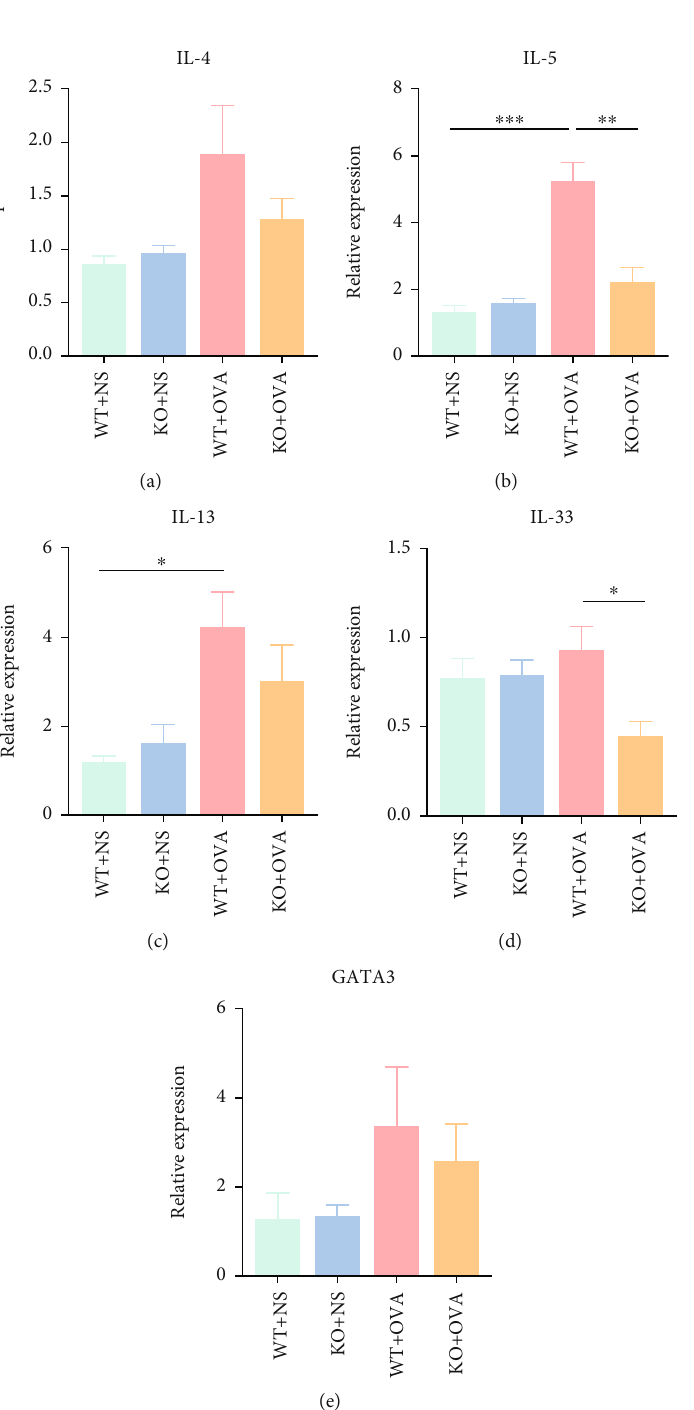
Figure 6: The expression levels of mRNA in mice nasal mucosa using qPCR. The expression levels of (a) Il4 , (b) Il5 , (c) Il13 , (d) Il33 , and (e) Gata3 in the nasal mucosa ( n = 3 in NS groups; n = 5 in OVA groups). All data represent mean ± SEM . AR: allergic rhinitis; OVA: ovalbumin; NS: normal saline. ∗ P < 0 : 05 , ∗∗ P < 0 : 01 , and ∗∗∗ P < 0 : 001